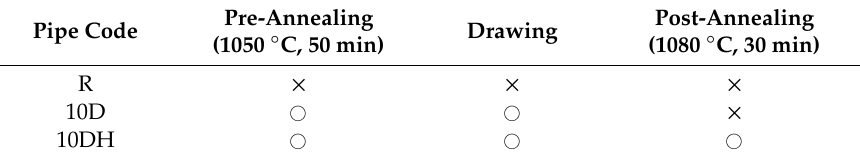
Table 5. Heat treatment and drawing process conditions of welding